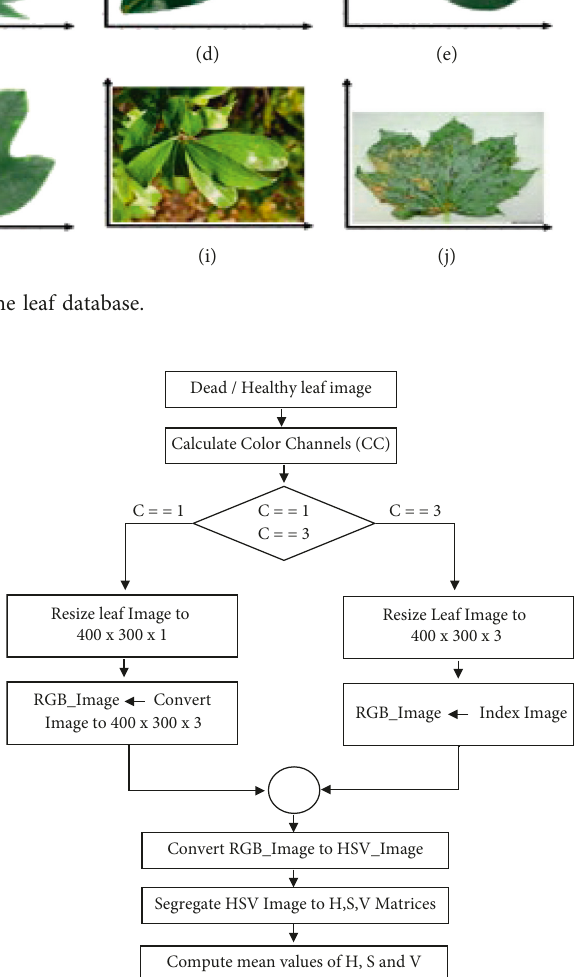
Figure 4: Flow chart of the HSV